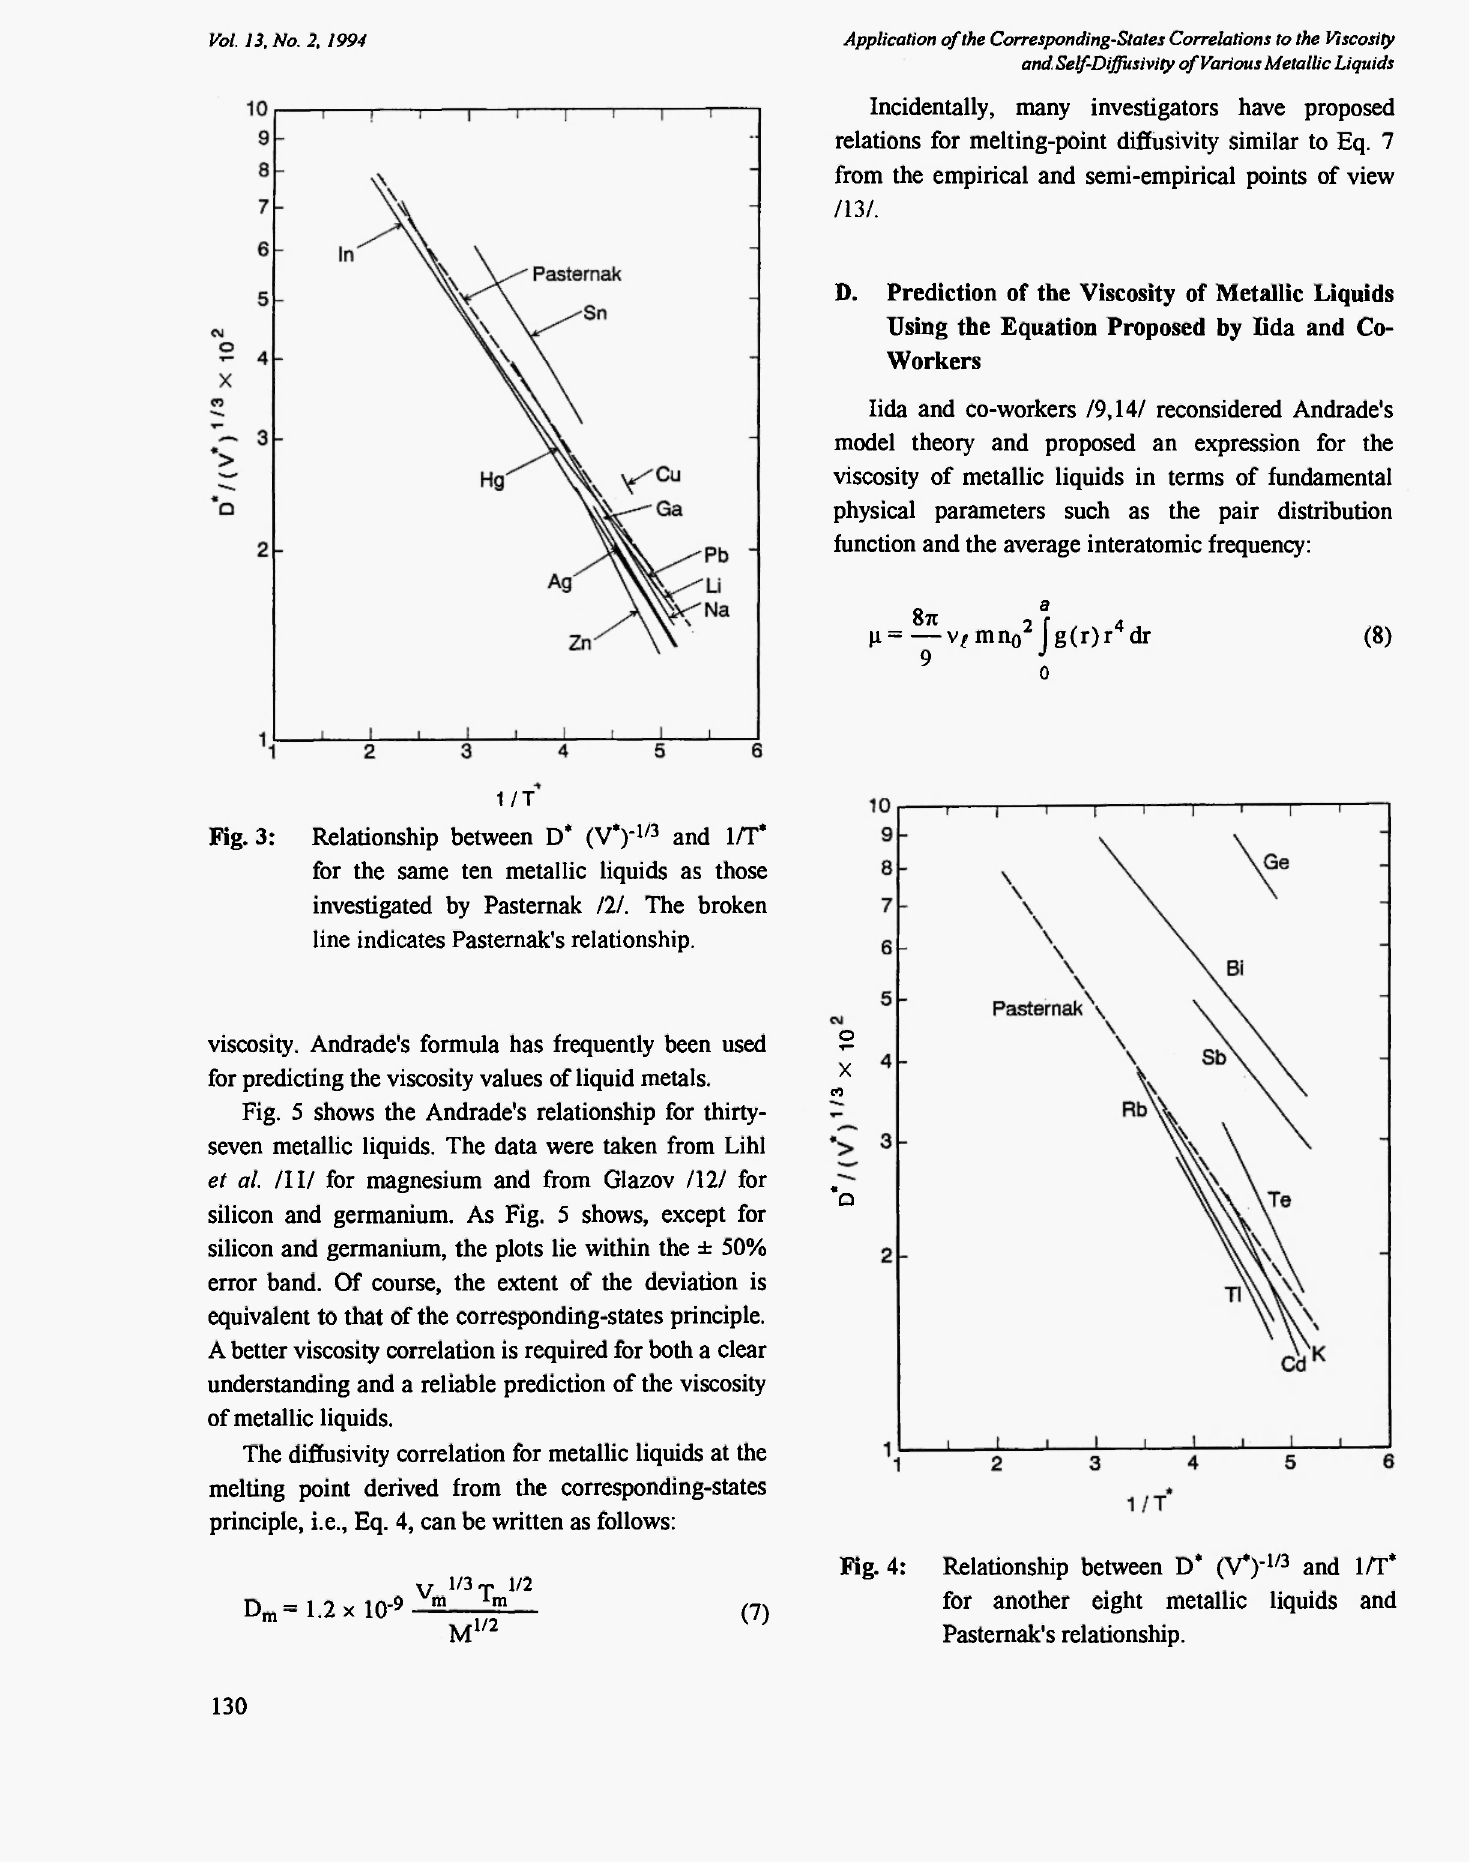
Fig. 4: Relationship between D* (V)" 1/3 and 1/T* for another eight metallic liquids and Pasternak's